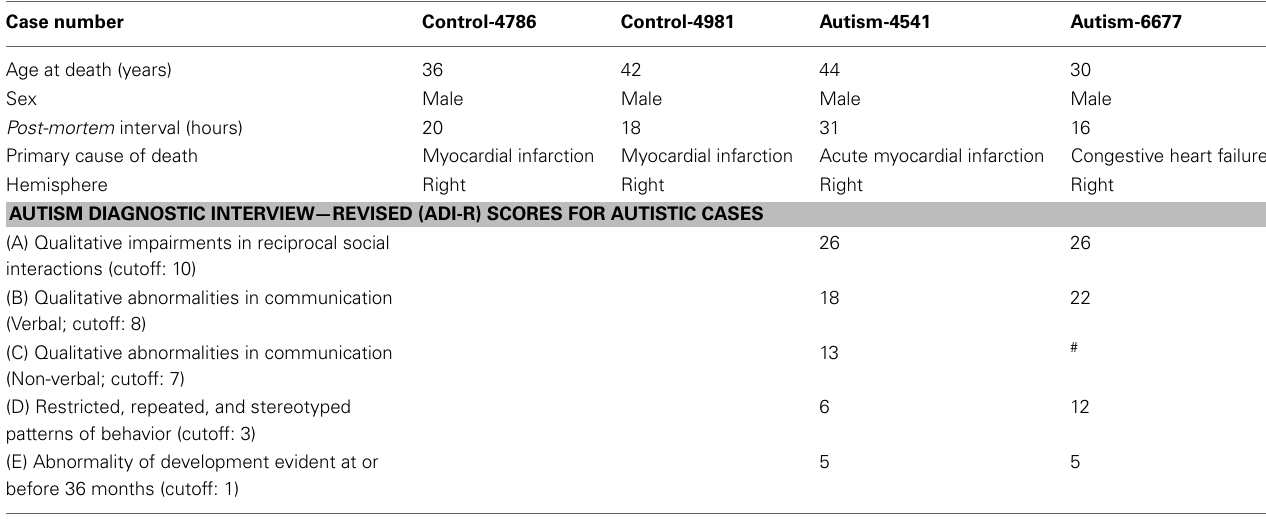
Table 1 | Clinical characteristics of post-mortem cases